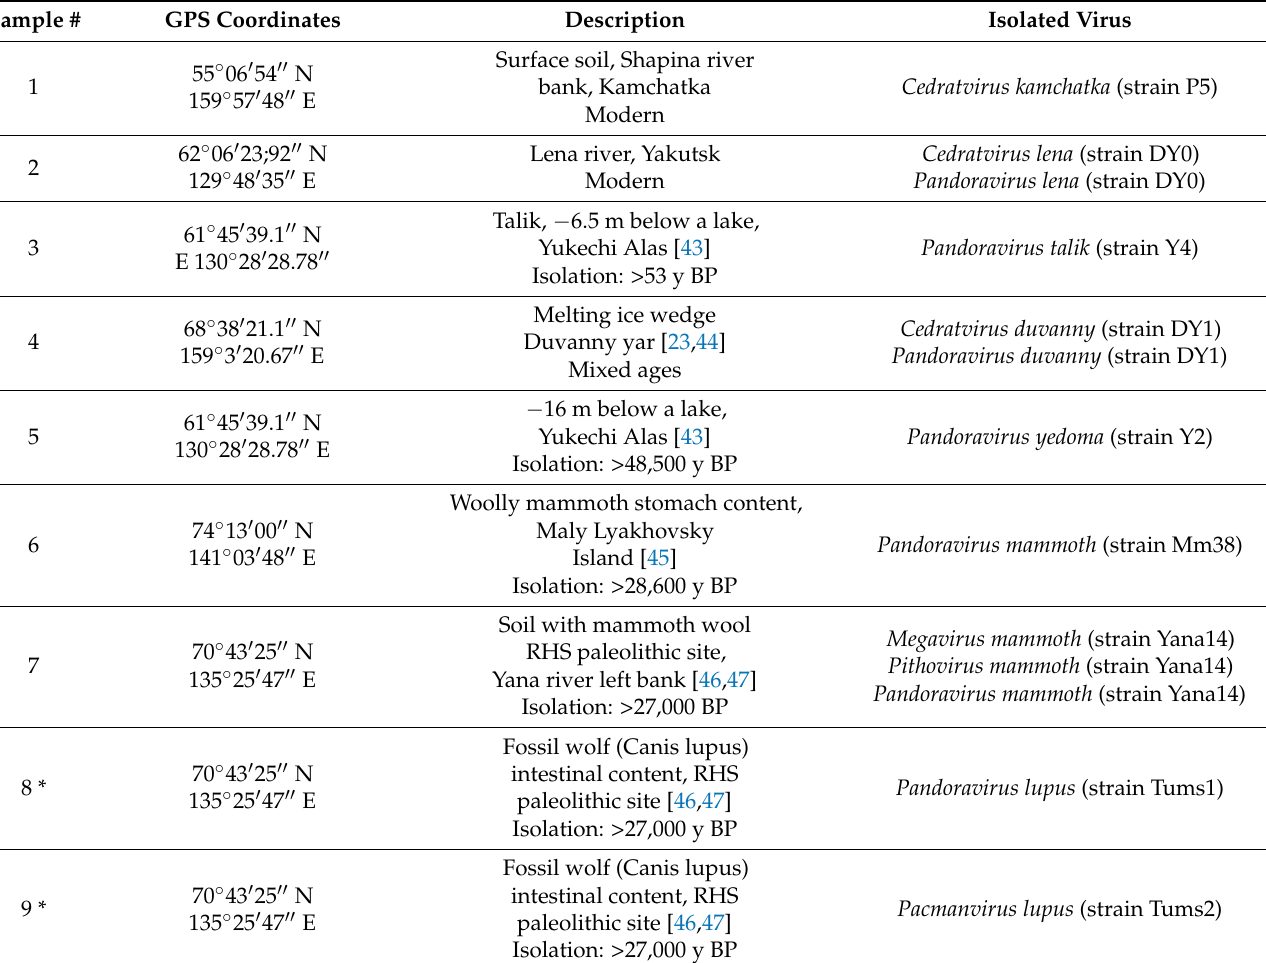
Table 1. Samples and virus